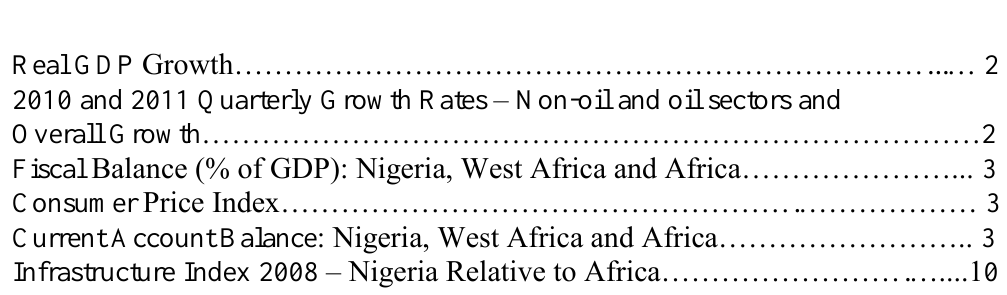
GRAPHS Graph 2 2010 and 2011 Quarterly Growth Rates – Non-oil and oil sectors and Graph 3